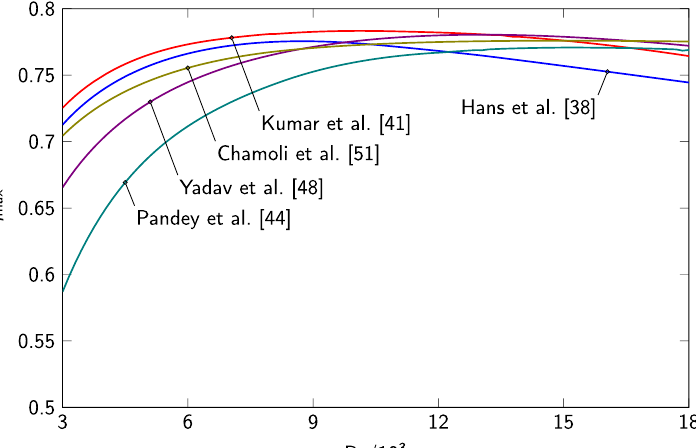
Figure 21. Relationship between η max and Re for the best performing absorber plates and ˙ G = 500Wm − 2 .